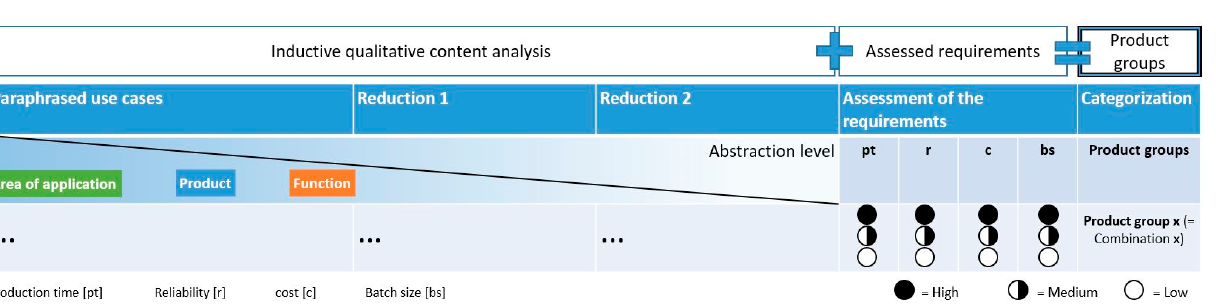
Figure 3. Short excerpt of the inductive categorization of use cases with requirements to create product groups (methodology).